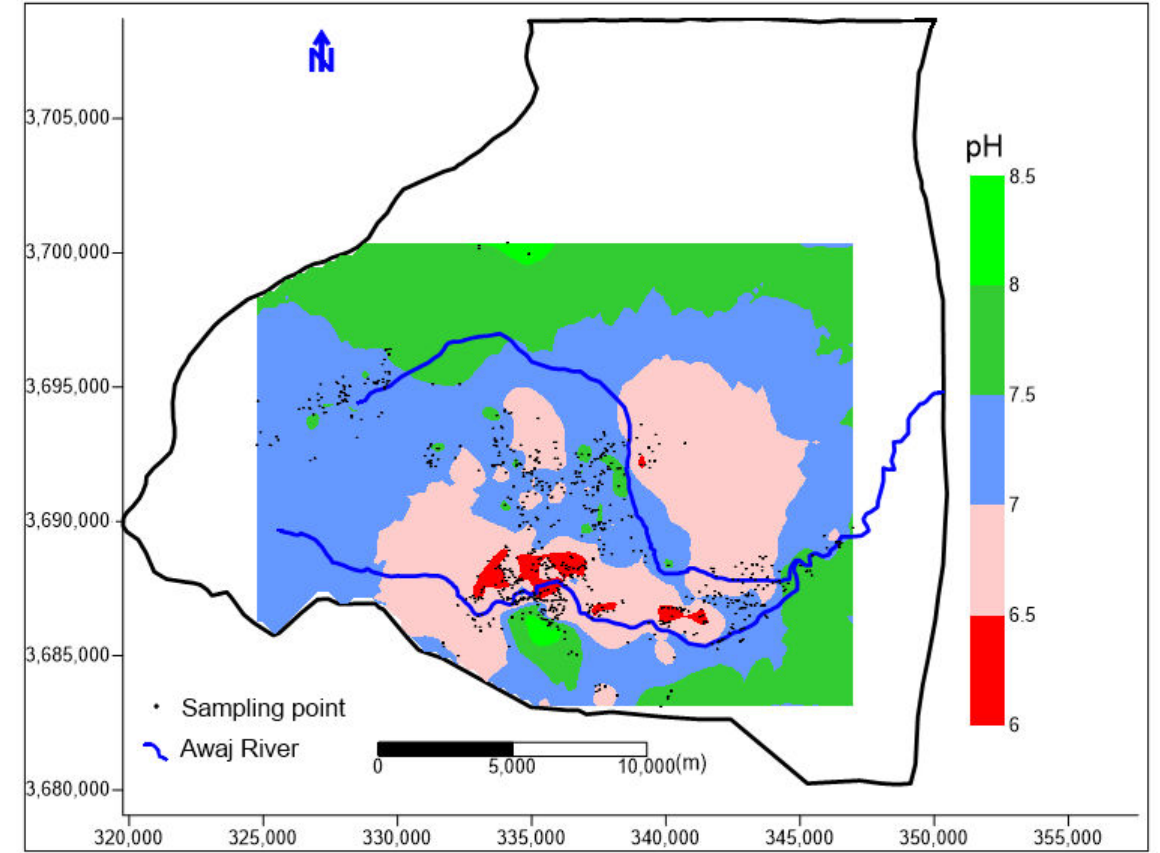
Figure 13. Spatial distribution of pH values in groundwater samples based on available data of field survey conducted from July to August